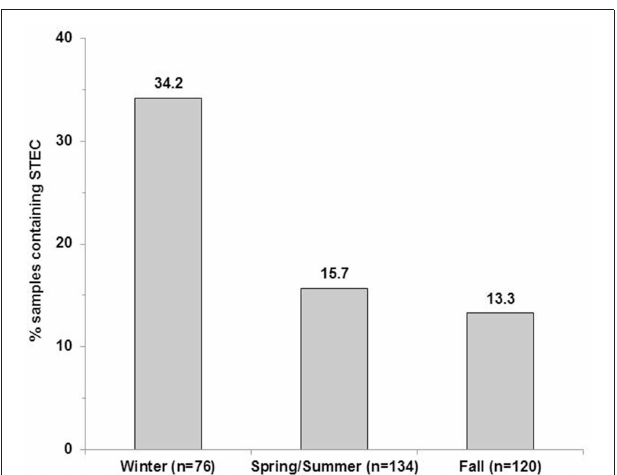
FIGURE 2 | STEC prevalence in surface water samples collected in the Lower Fraser, Sumas, Nicomekl and Serpentine River watersheds of the Lower Mainland of British Columbia, Canada. Columns show the proportion of surface water samples (%) from which STEC were